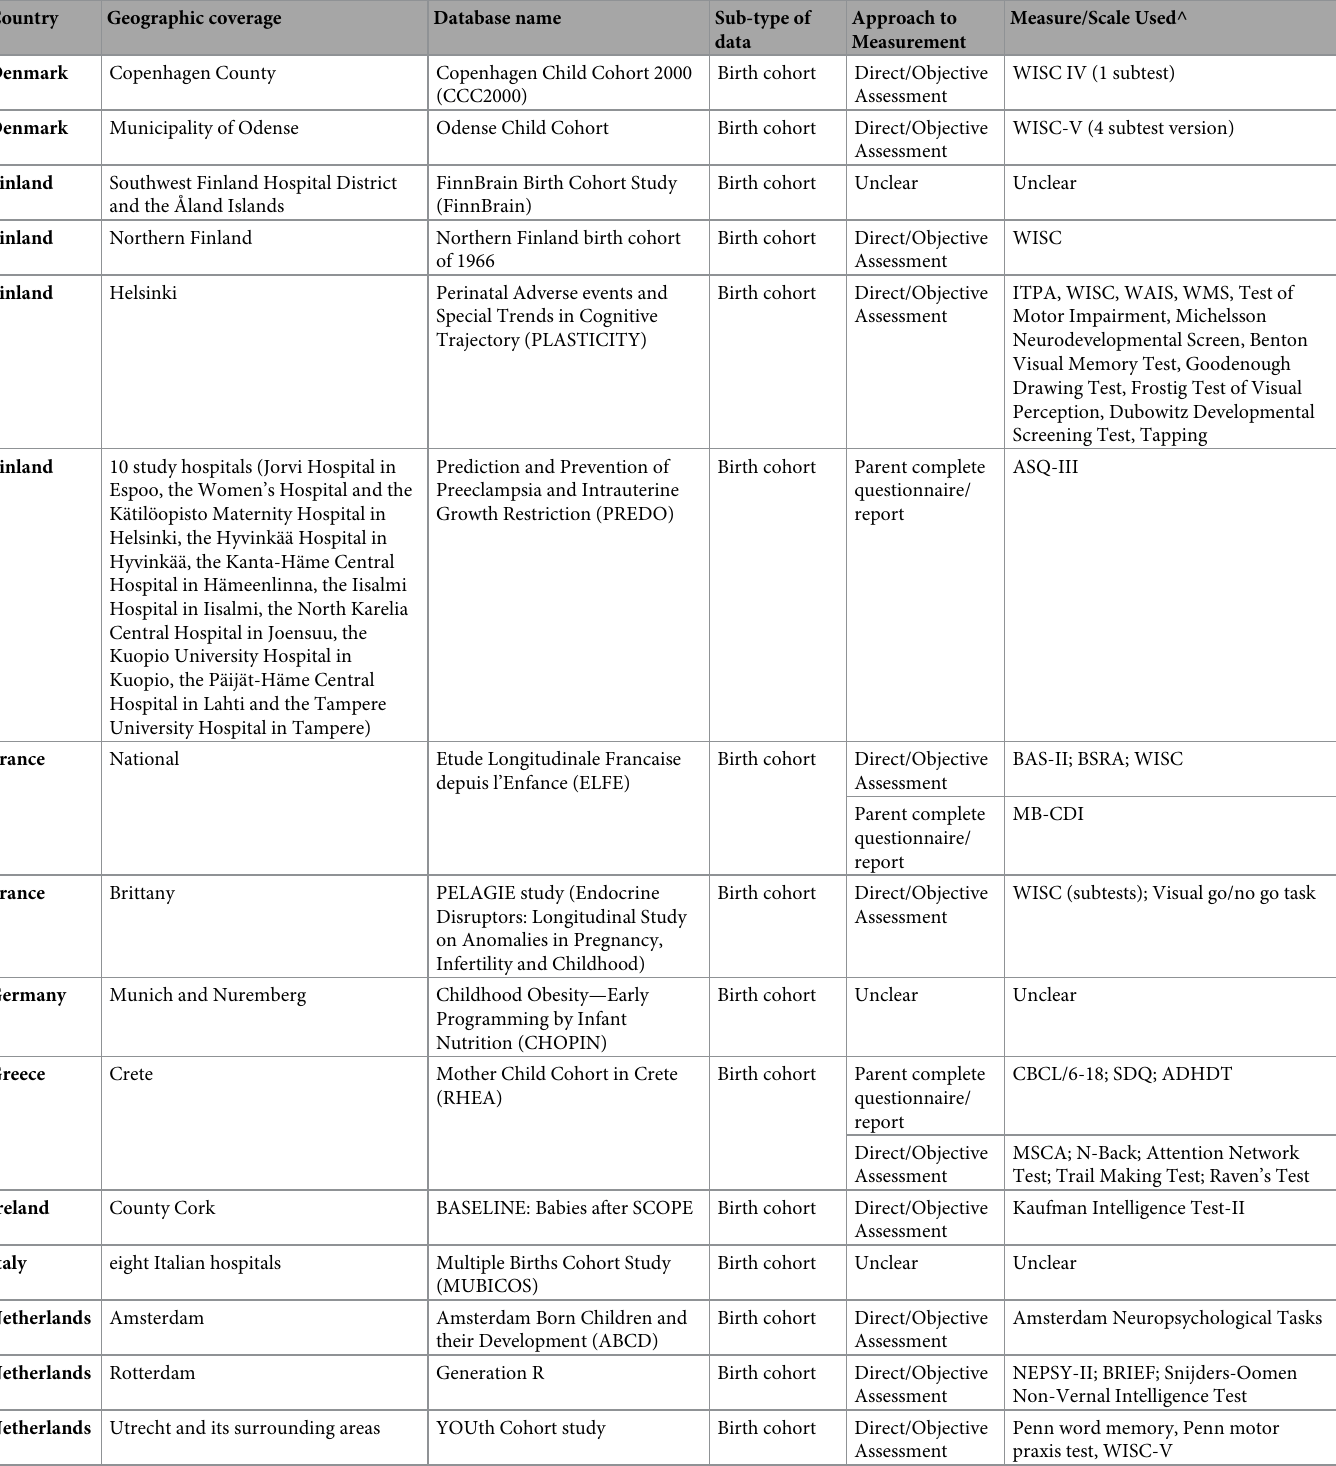
Table 3. Data sources which record cognitive